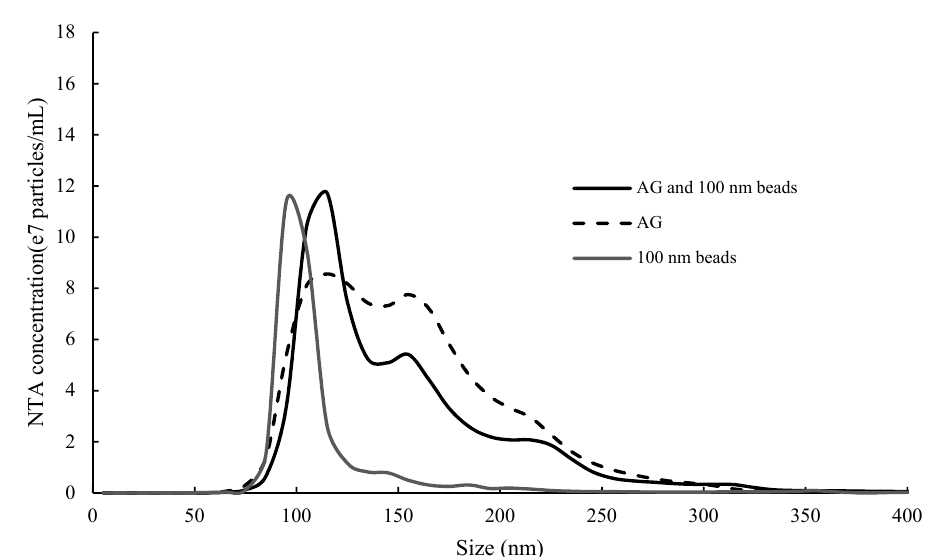
Figure 6. Size distribution of 100 nm polystyrene beads, AG and their mixture, determined by nanoparticle tracking analysis.